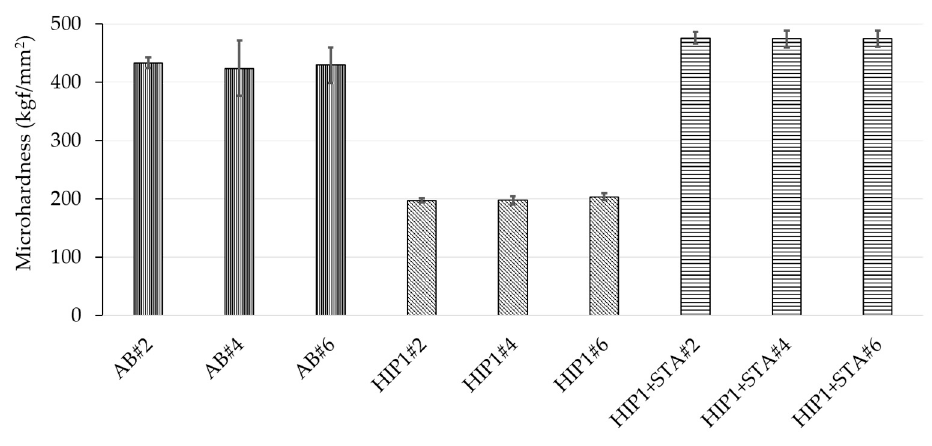
Figure 7. Microhardness values of the as-built and post-treated samples #2 (LS = 125 µm), #4 (LS = 225 µm), #6 (LS = 325 µm).